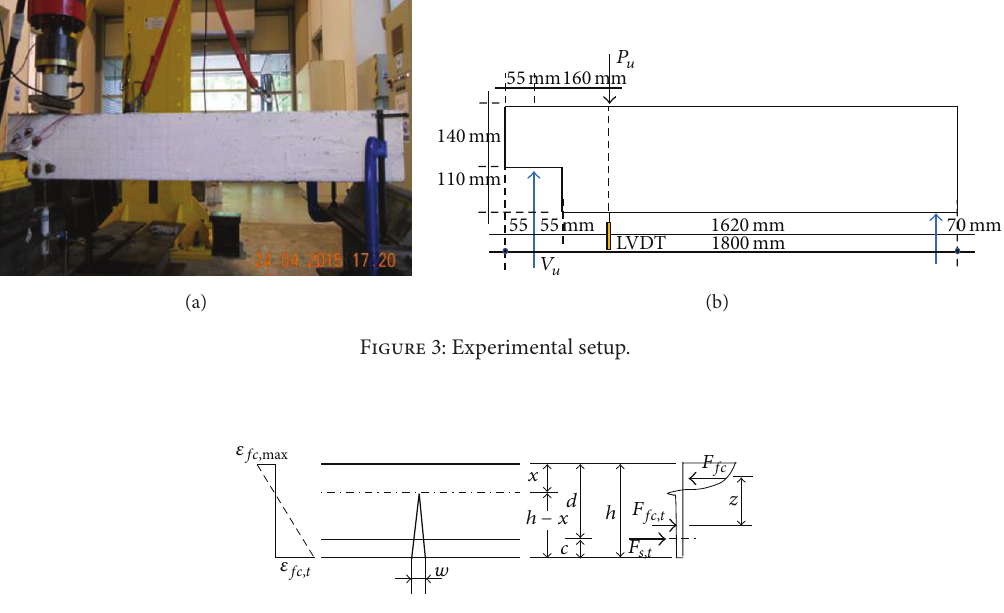
Figure 4: The stress-strain relationship, RILEM [20, 21].